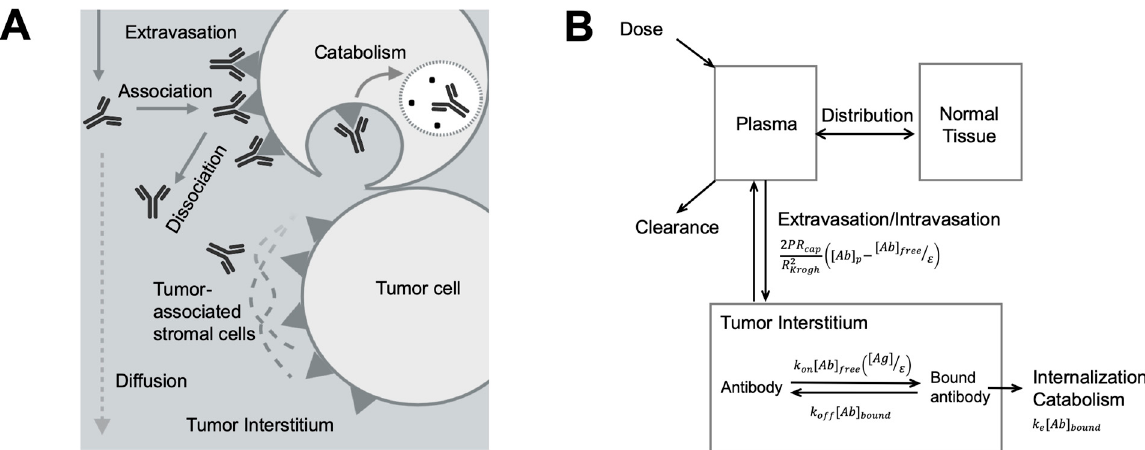
Figure 3. Antibody spatial distribution in tumors. ( A ) Target interaction and tumor microenvironment influence antibody spatial distribution. After extravasation into the tumor interstitium, antibodies rapidly associate with its targets in peri- vascular tumor cells, forming a binding site barrier and limiting its diffusion to the deeper tumor. Antibodies bound to the targets can be endocytosed and degraded. Other components, such as tumor-associated stromal cells, also hinder an- tibody interaction with its targets and antibody diffusion. ( B ) A simplified antibody spatial distribution model in tumors . The plasma, normal tissues, and the tumor were included in a simplified Krogh Cylinder model. The arrows indicated antibody movements between compartments . The arrows indicated antibody movements between compartments. The antibody extravasation was a function of P (the permeability coefficient for antibody across the tumor capillary wall), R cap (the capillary radius in the tumor), R Krogh (the average radius of tissue surrounding each blood vessel), [ Ab ] p (antibody concentration in the plasma), [ Ab ] free (free antibody concentration in the tumor), and ε (void fraction). In the equation describing antibody binding, k on is association rate constant, k off is disassociation rate constant, [ Ag ] is the target concen- tration in the tumor, and [ Ab ] bound is the concentration of bound antibodies. Bound antibody internalization is described by the degradation rate constant k e . (Adapted from Figure. 1A [137], Elsevier, 2012).